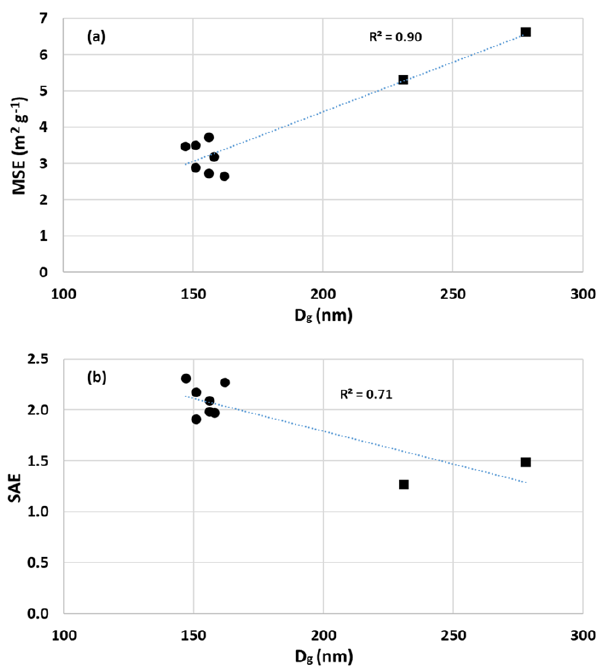
Figure 4. (a) Mass scattering efficiency (MSE) versus geomet- ric mean diameter ( D g ) from the SMPS size distribution of the 2019 BB events observed at MBO, with linear regression and correlation coefficients shown. (b) D g and SAE for the August– September 2019 events observed at MBO, with linear regression and correlation coefficients shown. The Siberian BB events are shown with squares and all others as circles. Both relationships are statistically significant with P < 0 .